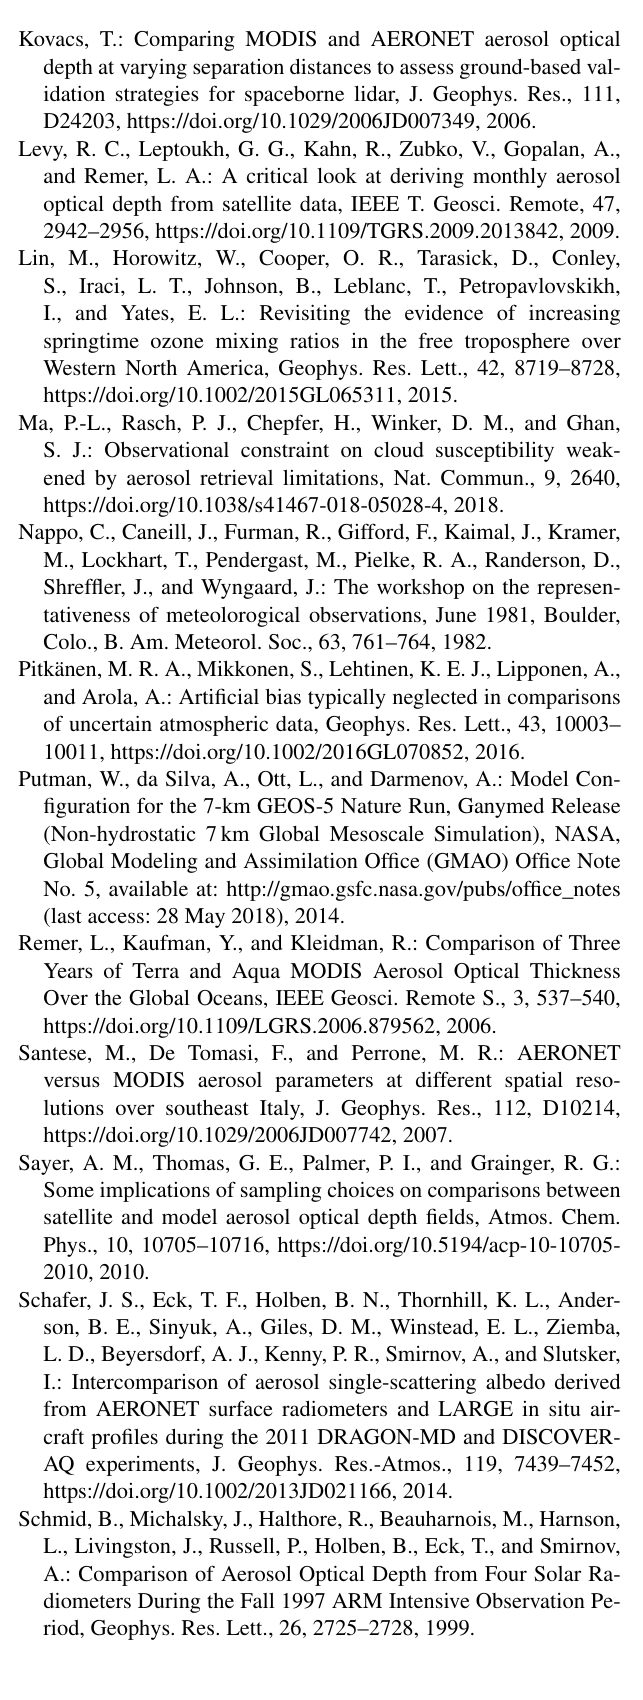
figuration for the 7-km GEOS-5 Nature Run, Ganymed